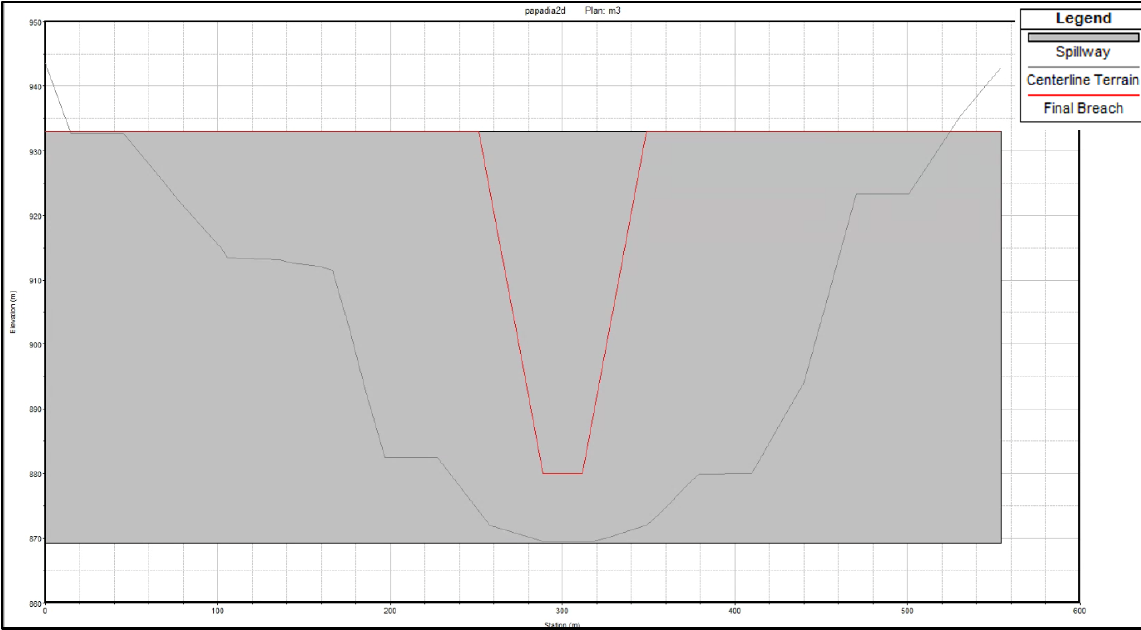
Figure 7. Final dam breach geometry plot (piping).